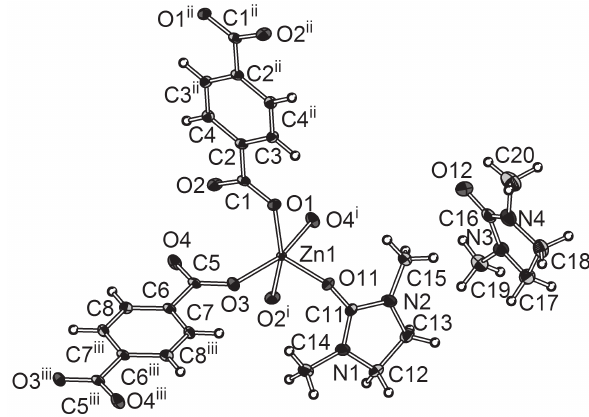
Table 1: Data collection and handling.